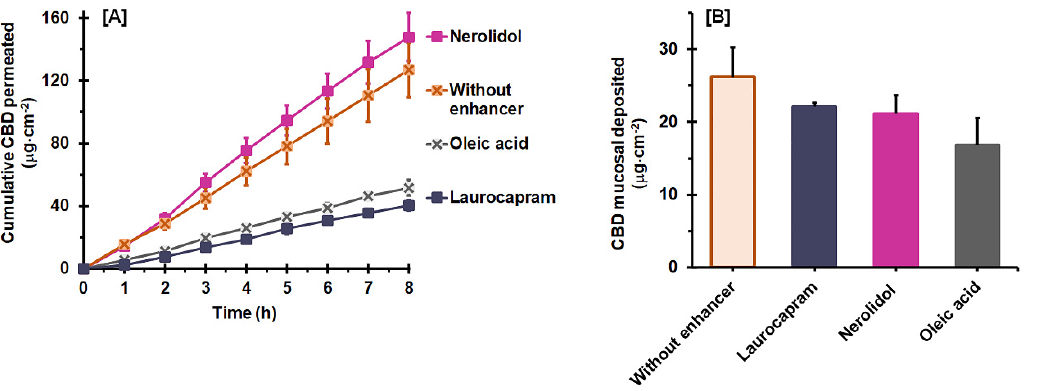
Figure 5. Effect of combined enhancers on ex vivo CBD permeation ( A ) and deposition ( B ) with the 25:75 DEGEE:MCT binary vehicles (mean ± SD, n = 4).